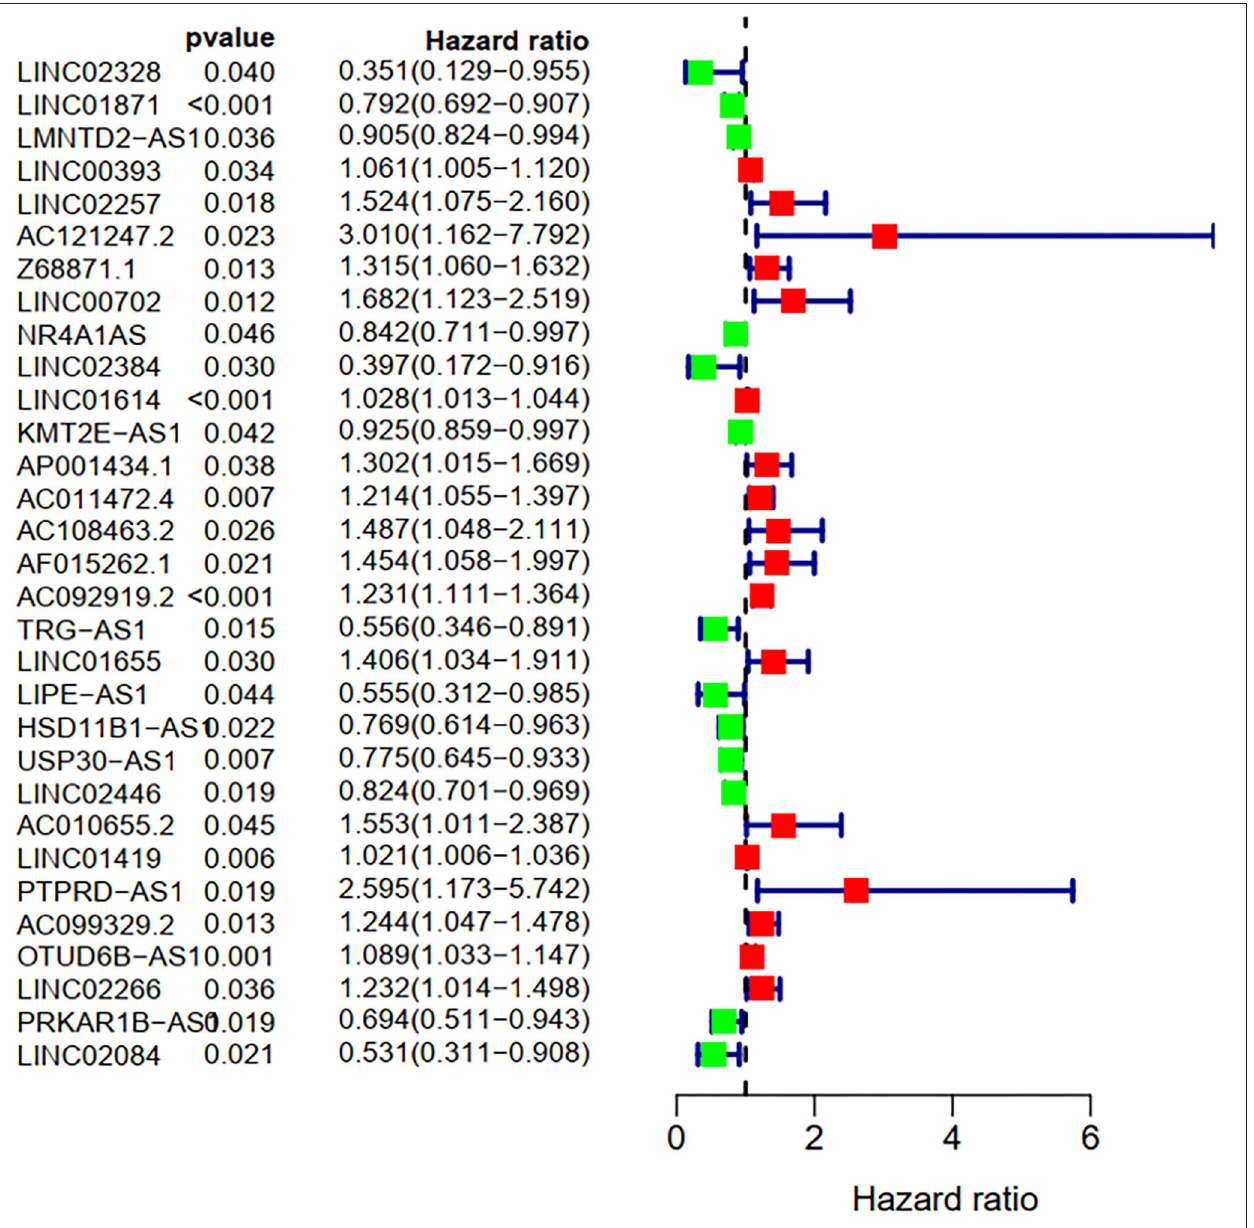
FIGURE 2 | Univariate Cox regression analysis of the FRLncRNAs related to prognosis. The red and green boxes represent risk factors or protective factors, respectively.